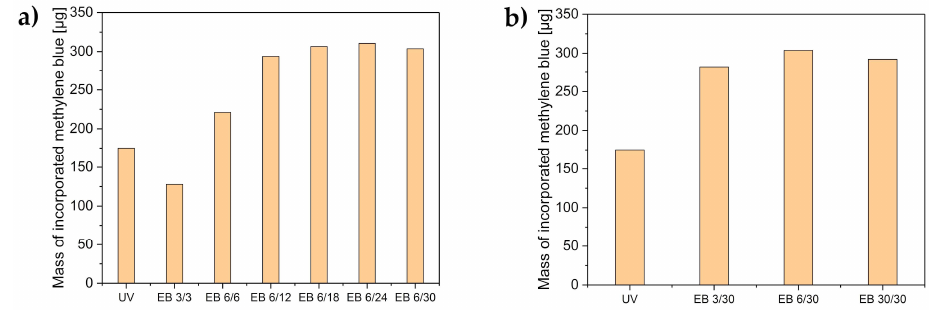
Figure 5. Methylene blue uptake of the UV-cured hydrogels compared to the hydrogels cured with electron beam, with the variation of ( a ) the total doses and ( b ) the differential doses.